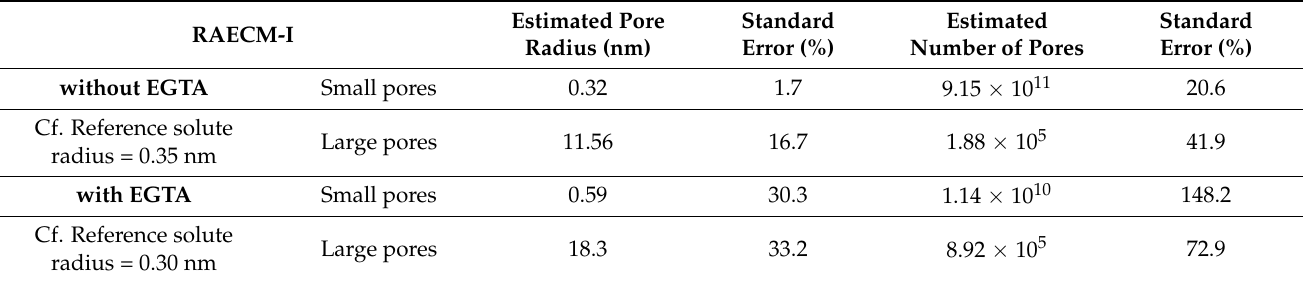
with EGTA Small pores 0.59 Cf. Reference solute